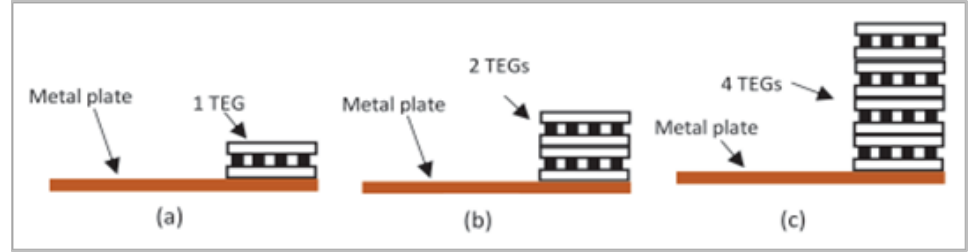
Figure 13. TEG module configurations; ( a ) 4 × 1, ( b ) 2 × 2, ( c ) 1 × 4 [92].